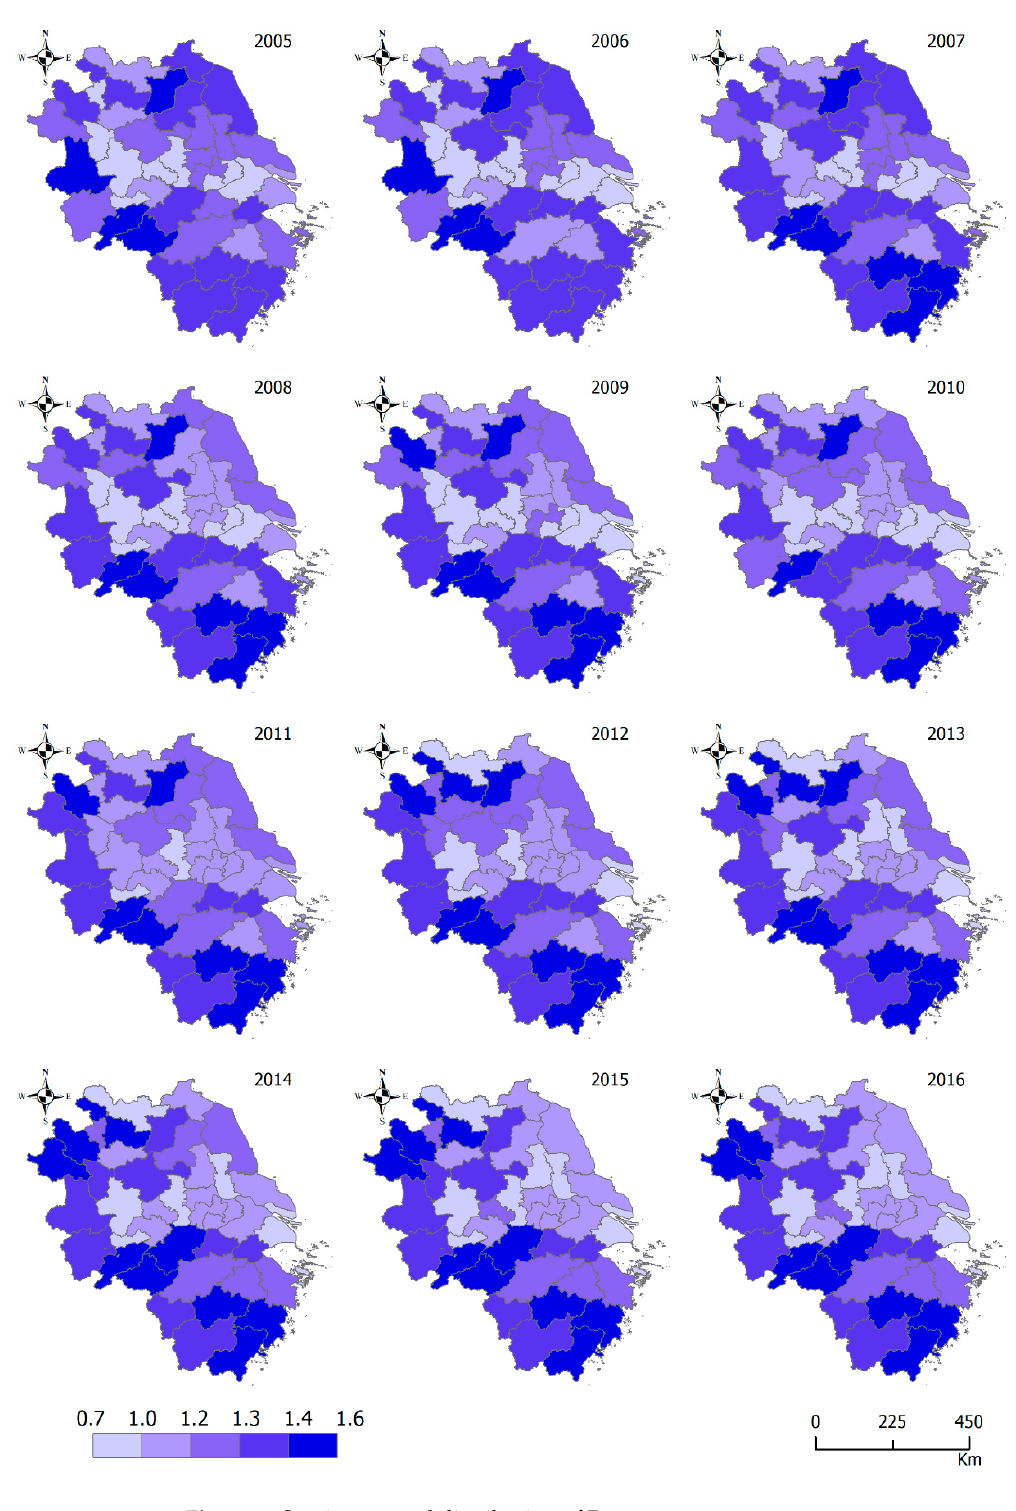
Figure 7. Spatiotemporal distribution of Porter.